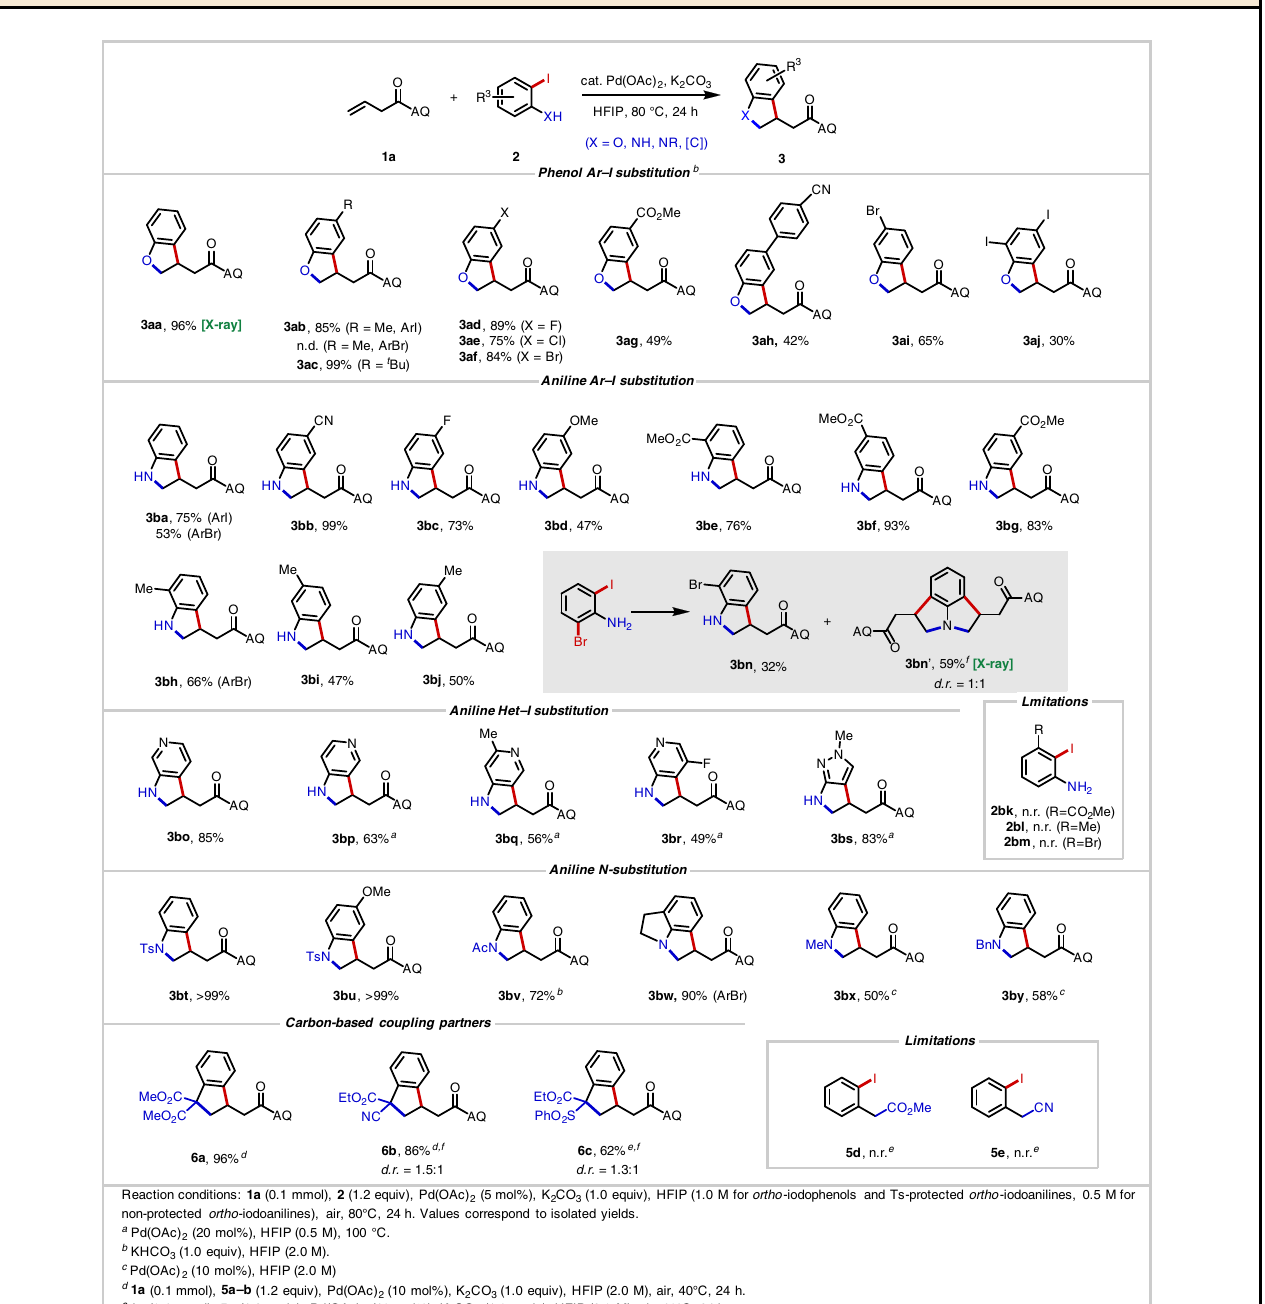
f Values correspond to yields of a mixture of